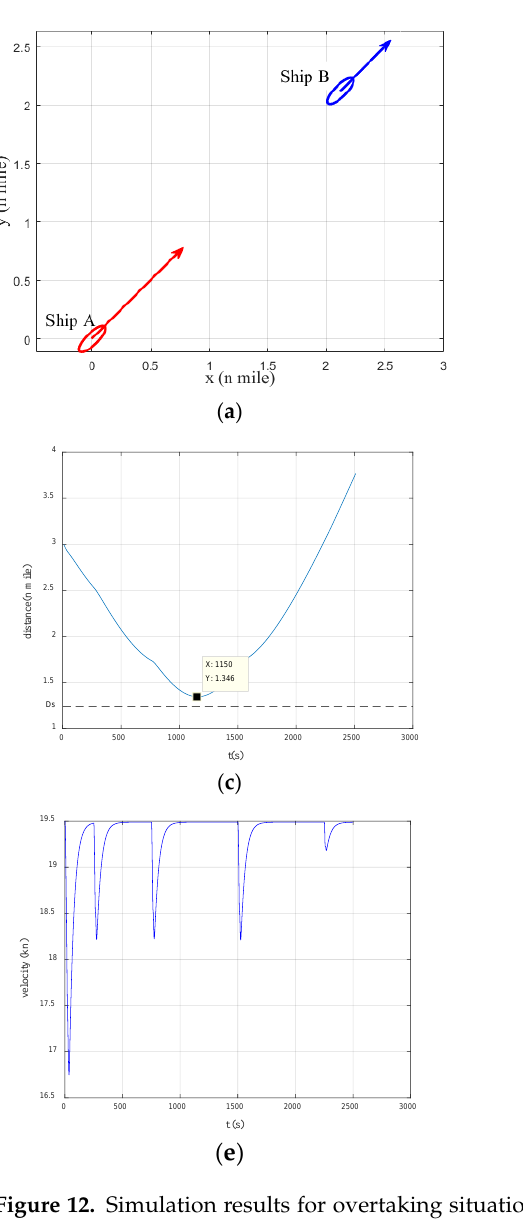
( f ) Figure 11. Simulation results for a small crossing angle situation. ( a ) Initial traffic configuration; ( b ) optimal trajectory; ( c ) relative distance; ( d ) rudder angle of ship A; ( e ) velocity of ship A; and ( f )